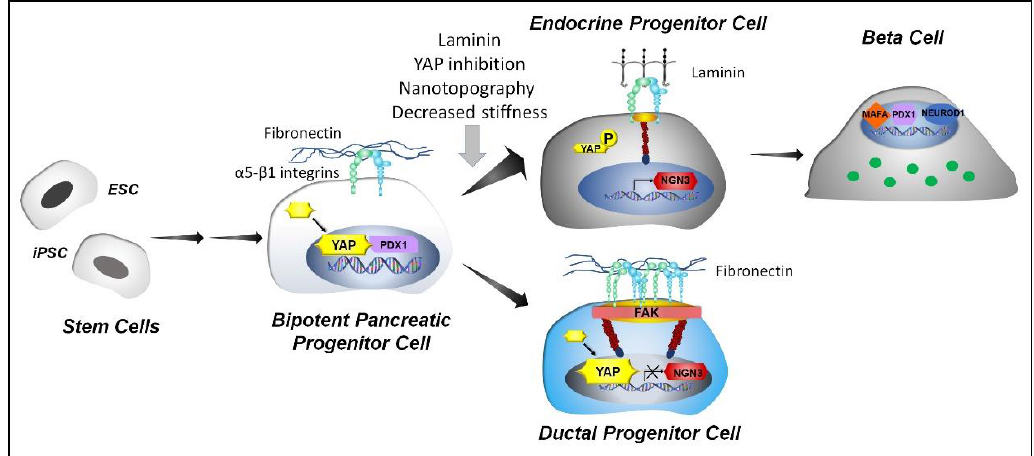
Figure 4. YAP signaling controls pancreatic β -cell maturation. The fate of bipotent pancreatic progenitor cells is under the control of the YAP transcription factor. Its activation promotes progenitor cell di ff erentiation toward a ductal fate and blunt endocrinogenesis, through suppression of NGN3. Its inactivation (via modification of ECM sti ff ness, nanotopography, geometry, exposure to laminin, or pharmacological inhibitors) is required to allow NGN3 expression and di ff erentiation toward an endocrine cell fate, characterized by expression of PDX1, Neurogenic di ff erentiation 1 (NEUROD1) and MAFA transcription factors, as well as